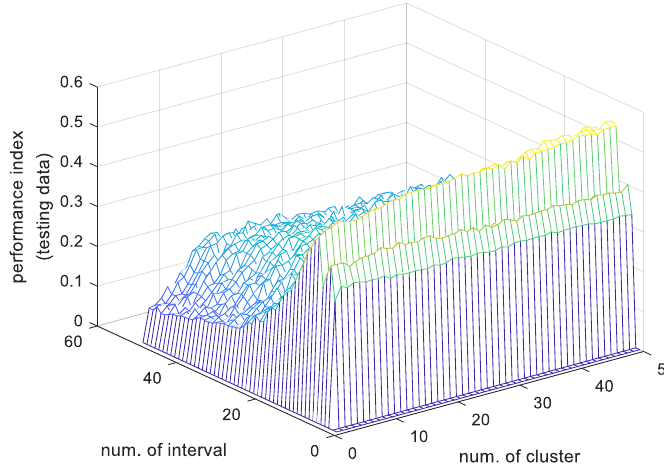
Figure 17. The variation of performance index (checking data).